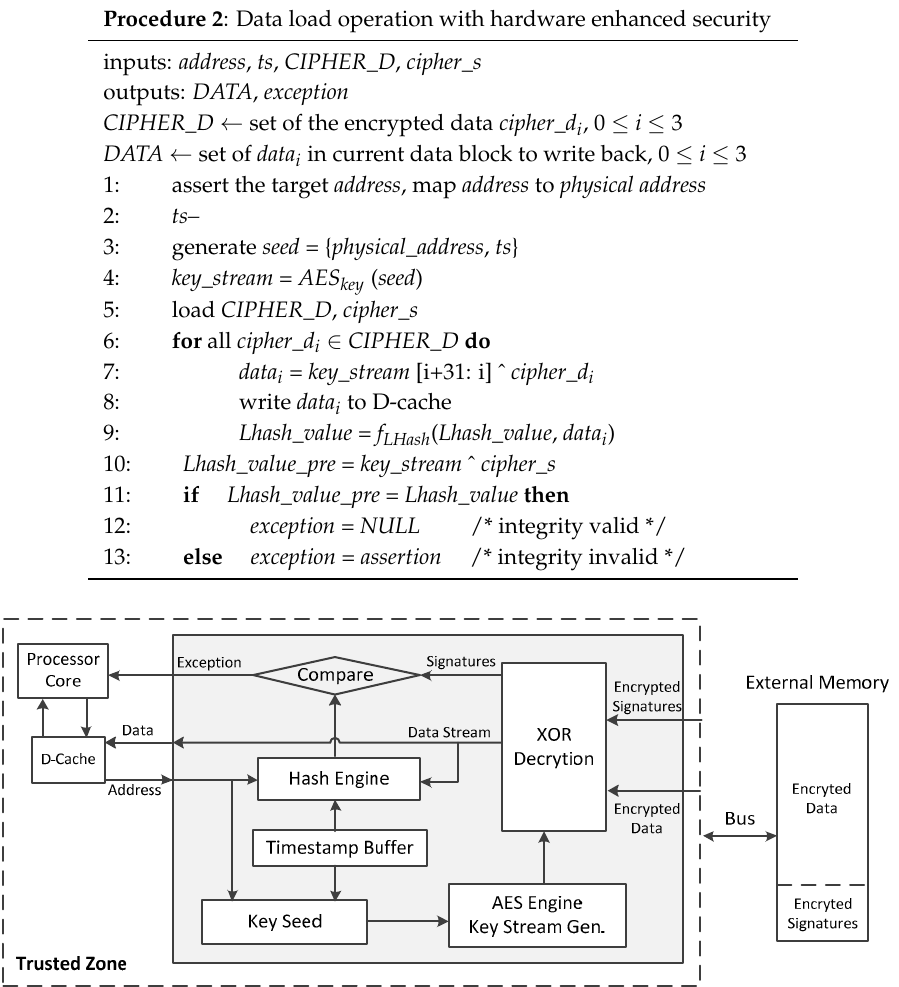
Figure 9. The hardware details of the data load operation.